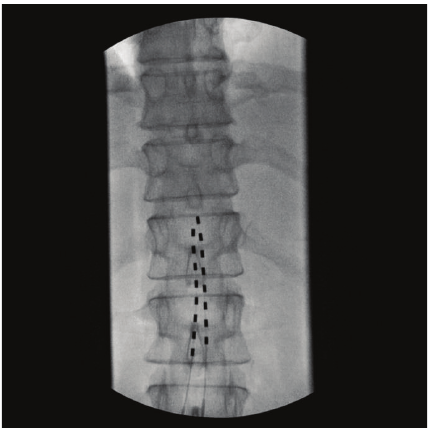
Figure 1: AP fluoroscopic view of SC trial placement.